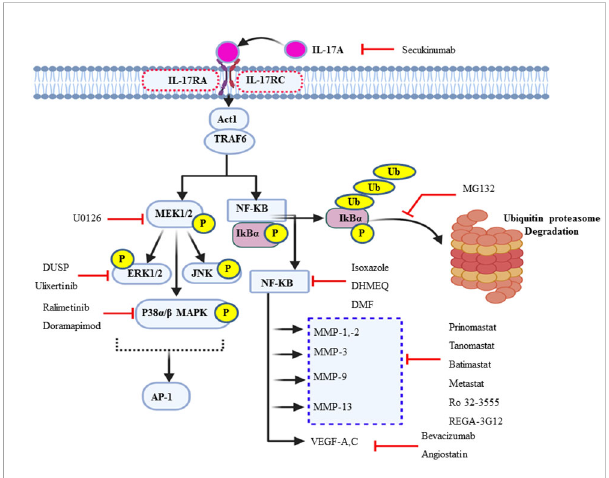
FIGURE 1 Schematic illustration of Th-17 polarization and its cytokine signature. Chemokines, including CCL2 and MCP-1, are secreted by cancer- associated fi broblasts (CAFs), tumor-associated macrophages (TAM), and antigen-presenting cells (APC) that promote CD4+ cell recruitment. Breast cancer cells, CAFs, TAMs, and dendritic cells are part of the stem cell and its microenvironment that produces different polarizing cytokines, such as IL-6, IL-23, and TGF- b . In turn, such polarizing cytokines activate distinct transcription factor cascades within naïve CD4+ T cells and in fl uence T cell differentiation into distinct effector T cell subtypes, mainly Th-17 effector cell subset that produces all IL-17 signature cytokines (IL-17A, IL-17B, IL-17C, IL-17D, IL-17E, and IL-17F) and IL-21 and